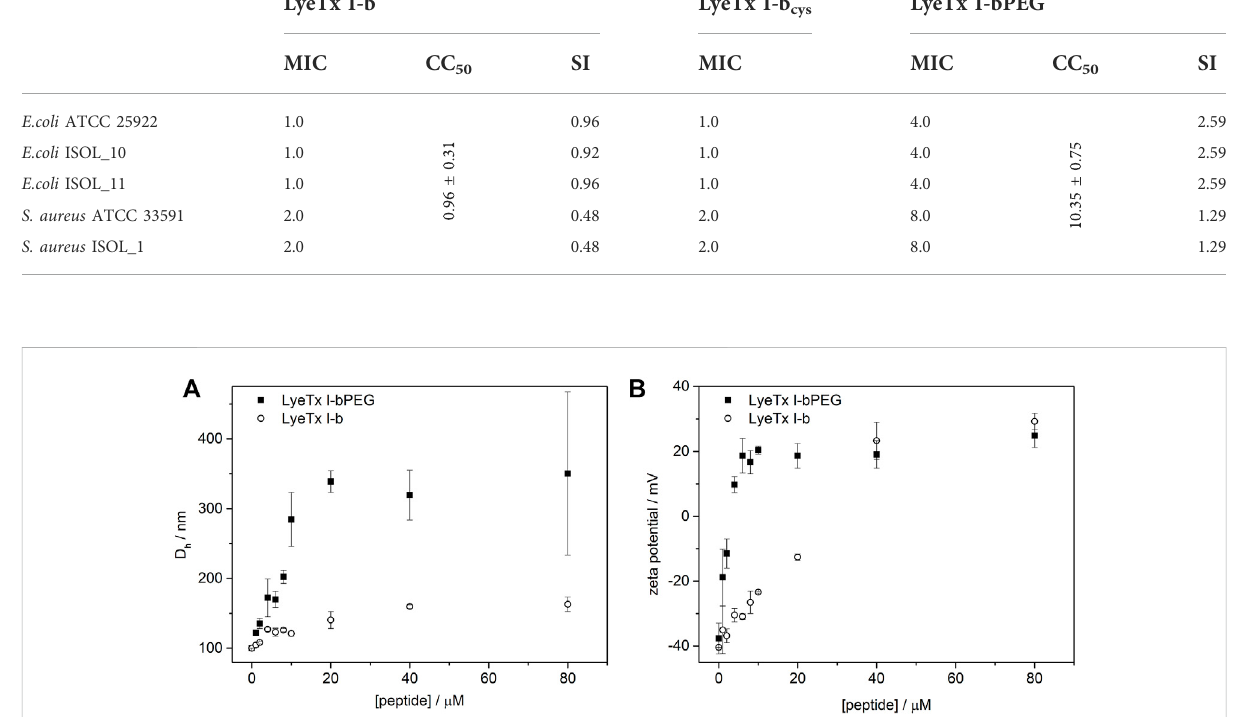
FIGURE 2 (B) normalized zeta potential ( ζ -potential) of POPC:POPG LUVs as a function of (circles) LyeTx I-b or (A) Hydrodynamic diameter ( D h ) and (squares) LyeTx I-bPEG concentration. LUVs containing 500 µM were suspended in 10 mM Tris-HCl buffer pH 8.0 at 25 ° C. Error bars represent the standard deviation of three independent